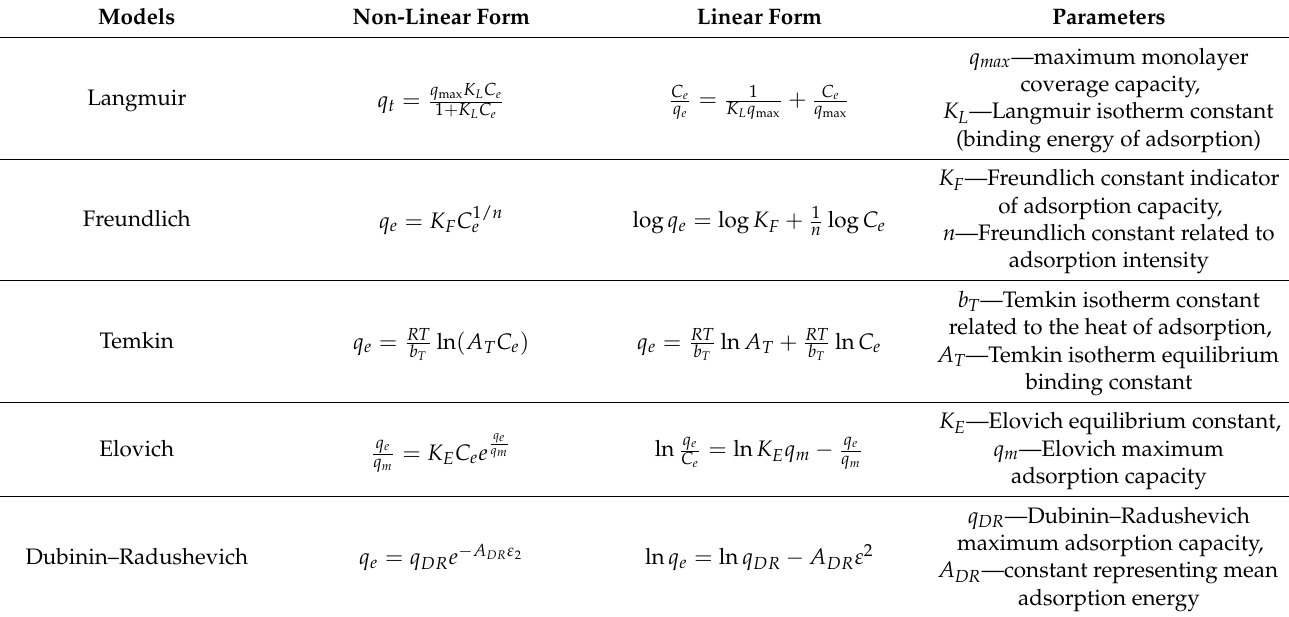
Table 1. Two and three parameters adsorption isotherm models (Nonlinear and linear form) [70,72–75].